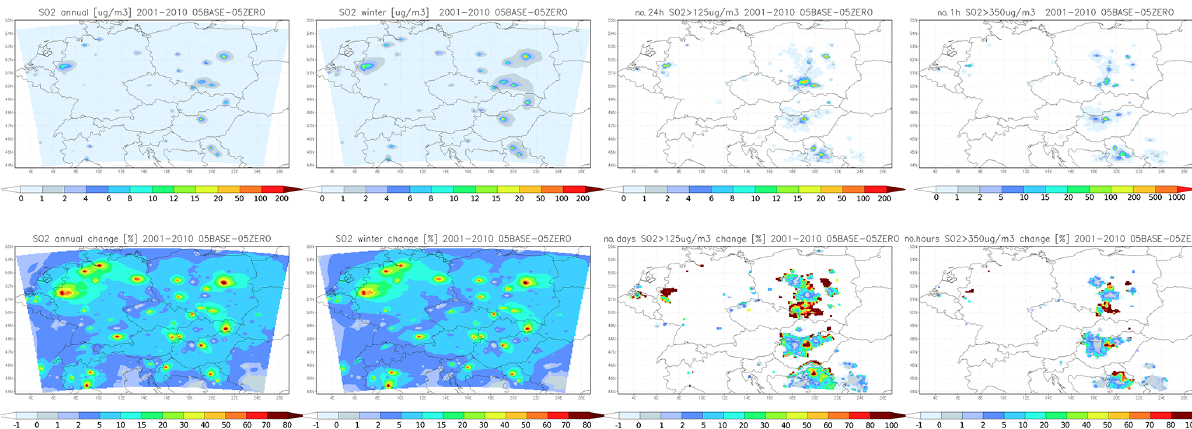
Figure 8. Impact of city emissions on SO 2 related air quality measures listed in Table 4: upper row shows the absolute change, the lower row the relative contribution from the urban